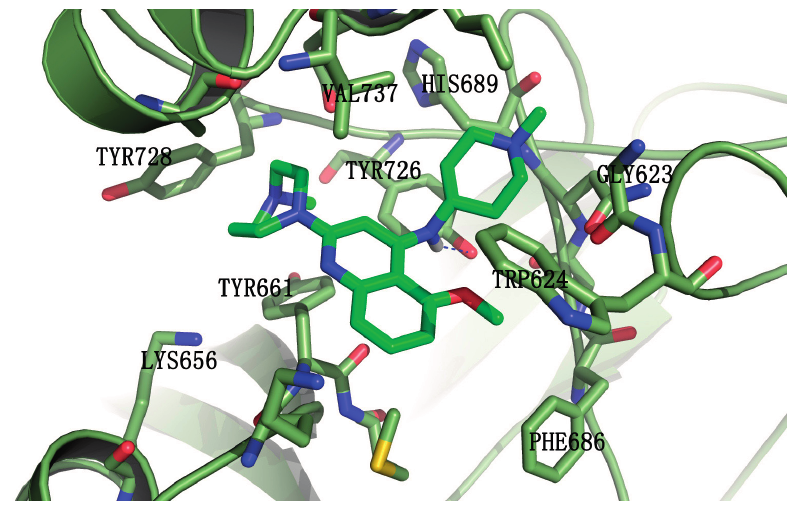
Figure 5. Predicted binding mode of compound 5k with the SET-domain of